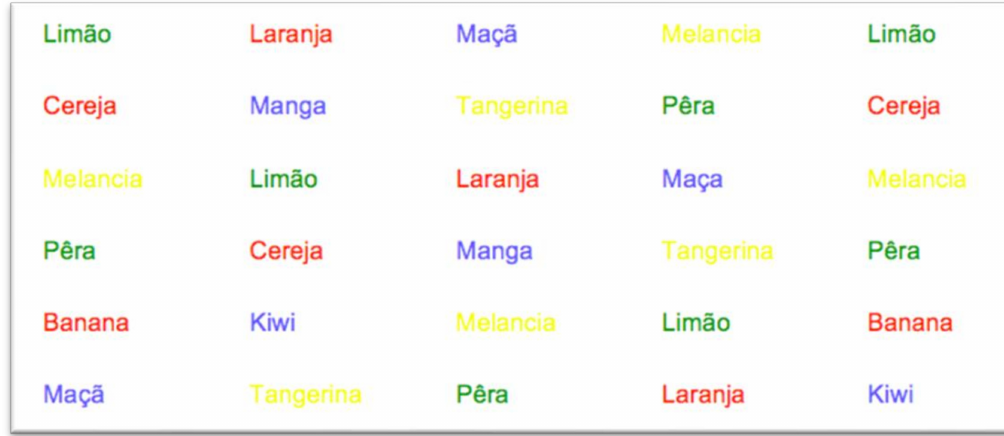
Figure 1. The ten neutral words.